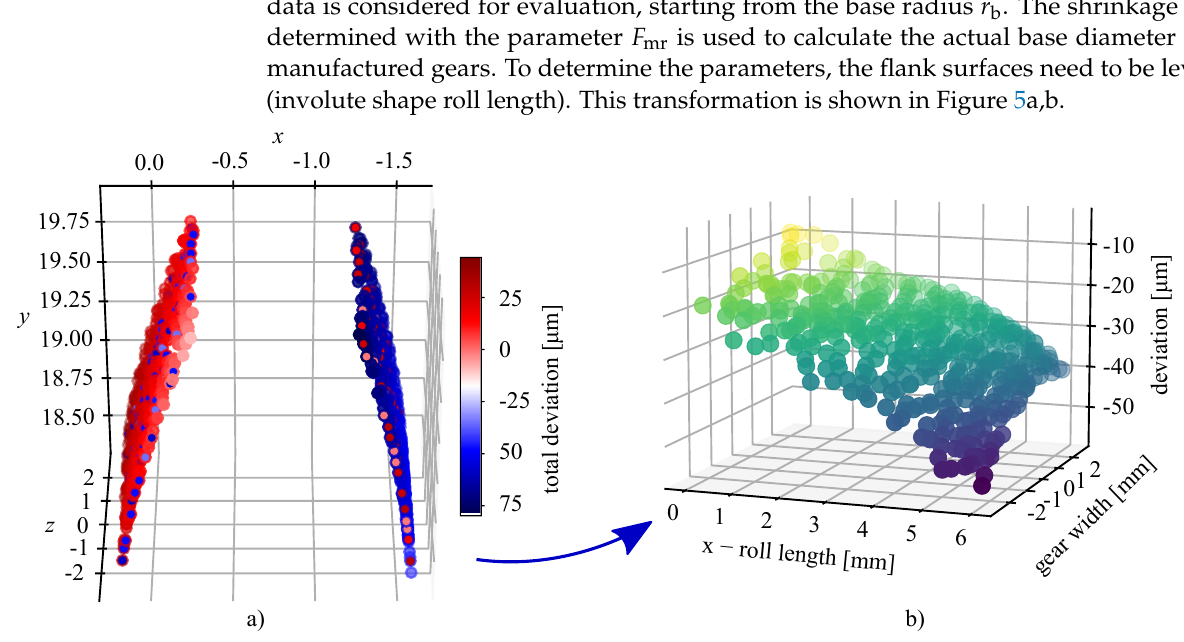
Figure 5. The process of determining the areal parameters for the characterisation of the surface flank deviation. ( a ) The evaluation area of the teeth. ( b ) Transformation of the data to the roll length for evaluation of the parameters.